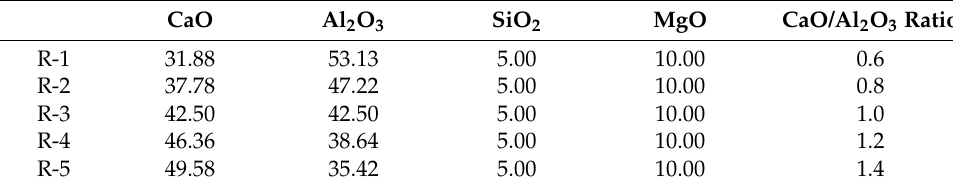
Table 2. Composition of different simulation